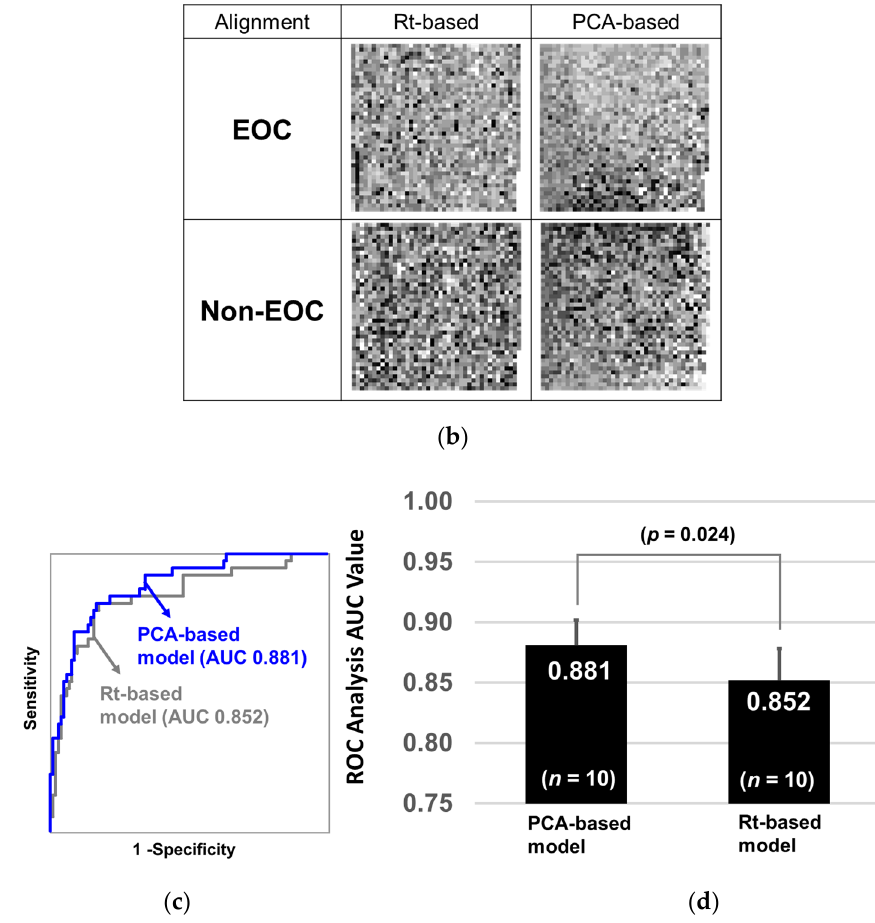
Figure 2. Alignment of glycopeptides to generate 2D barcode. ( a ) The Rt-based barcode was generated by aligning the glycopeptides from left-top to right-down by the order of elution time. The PCA-based barcode was developed by aligning the glycopeptides by the order of PCA loading values. ( b ) Typical Rt-based and PCA-based 2D-barcode images of the samples from patients with epithelial ovarian cancer (EOC) and of those with non-EOC. ( c ) After the two models were trained with 60% of the 351 barcodes, they were evaluated by the remaining 40% samples. The ROC curves are shown with a blue line (PCA-based) or with a gray line (Rt-based). ( d ) This process was repeated 10 times and the p -values of the Wilcoxon rank sum test were calculated between the two groups.